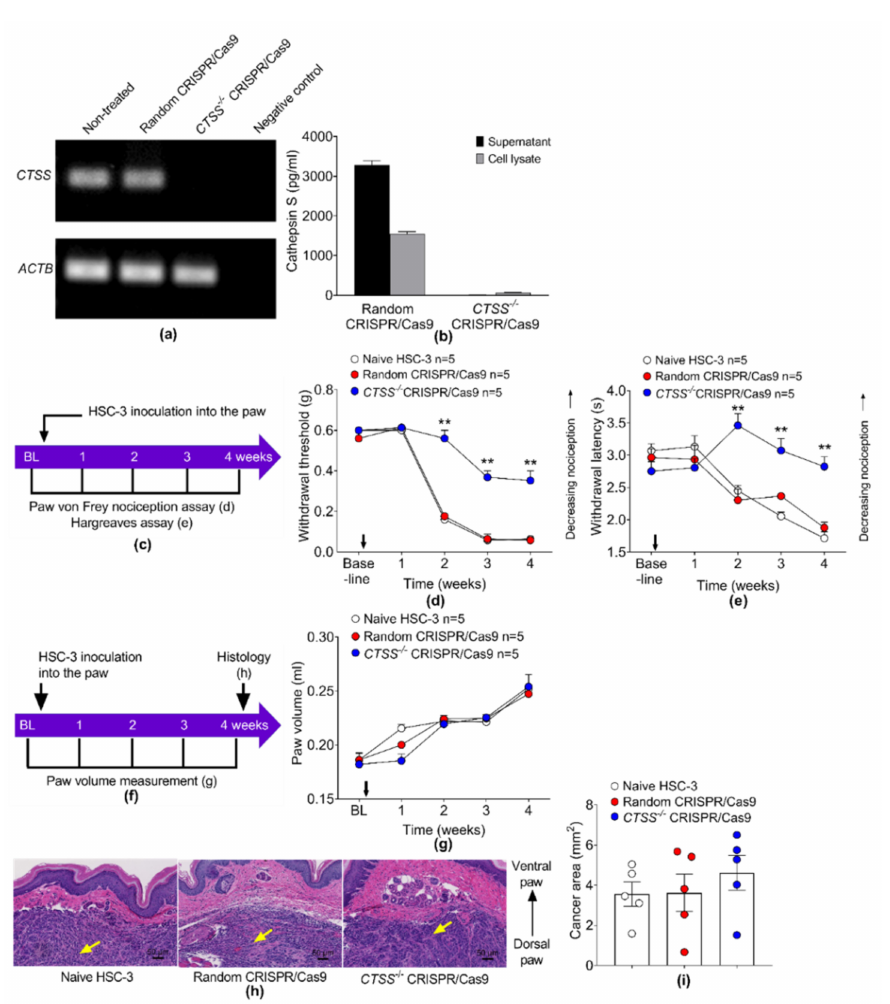
Figure 9. Deletion of CTSS with CRISPR/Cas9 in HSC-3 attenuates nociception, but not tumor volume or cancer area, in the mouse oral cancer xenograft model. ( a ) RT-PCR semi-quantitative analysis of CTSS expression in non-treated HSC-3 and HSC-3 treated with random CRISPR/Cas9 or CTSS − / − CRISPR/Cas9. No CTSS mRNA signal was detected in the HSC-3 CTSS − / − cells. Beta actin ( ACTB ) was used as a control. ( b ) CTSS − / − CRISPR/Cas9 reduced cathepsin S protein in supernatant and whole-cell lysate from HSC-3. ( c ) The experiment timeline for the inoculation of HSC-3 or HSC-3 CTSS − / − into the left hind paw of NU/J Foxn1 nu mice. The mice were tested with ( d ) paw von Frey nociception assay and ( e ) Hargreaves thermal assay. Cancer mice generated with HSC-3 CTSS − / − exhibited ( d ) a withdrawal threshold and ( e ) a withdrawal latency higher than cancer mice generated with HSC-3 treated with random CRISPR/Cas9. ** p < 0.01 HSC-3 CTSS − / − mice versus HSC-3 random CRISPR/Cas9 mice, two-way ANOVA. ( f ) In vivo experiment timeline of inoculation of HSC-3 CTSS − / − into the paw of NU/J Foxn1 nu mice for the measurement of tumor volume and cancer area. We measured the volume of the cancer paw before inoculation (BL), and every week until 4 weeks after inoculation. The cancer paws were collected for histological H&E staining at 4 weeks after inoculation. ( g ) HSC-3 CTSS − / − did not increase cancer paw volume in mice compared to cancer mice inoculated with HSC-3 treated with random CRISPR/Cas9. ( h ) Representative histological H&E images of the cancer (yellow arrow) in the paw inoculated with naive HSC-3 (left image), HSC-3 treated with random CRISPR/Cas9 (middle image), or HSC-3 CTSS − / − (right image). ( i ) Quantification of cancer area in each